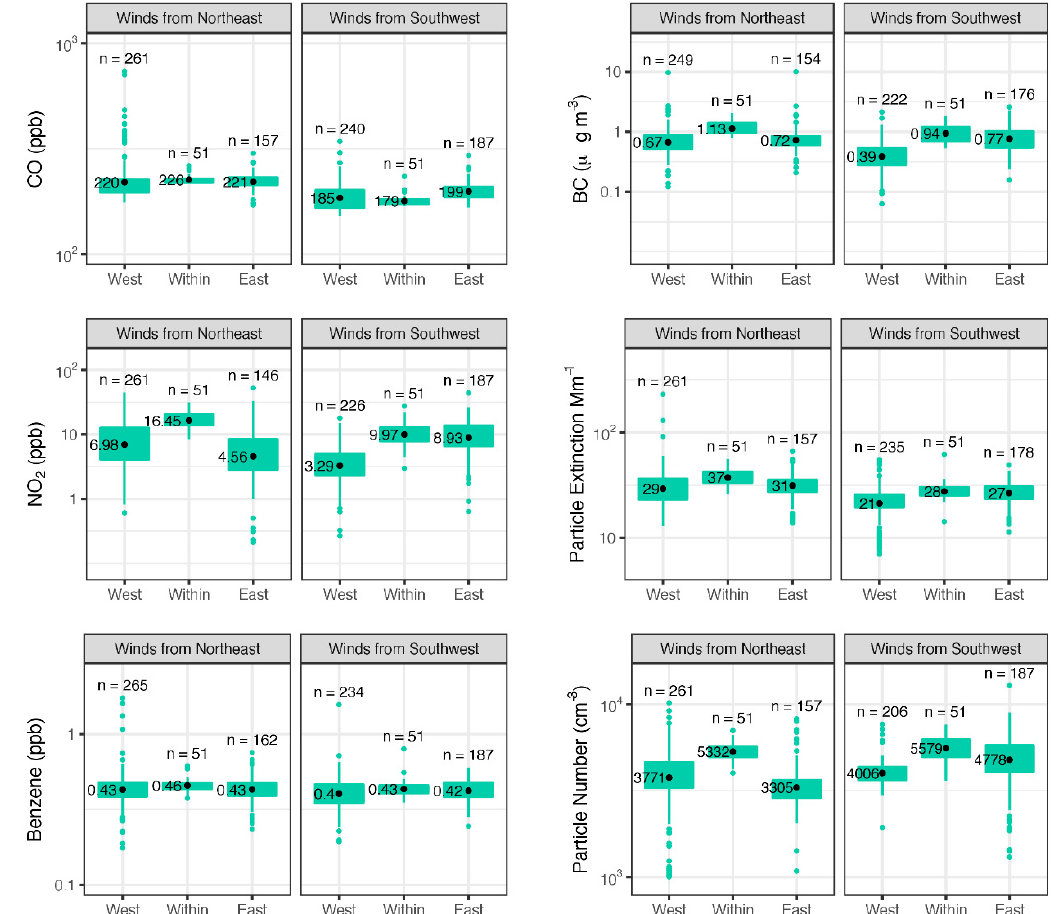
Figure 5. Concentration geometric means (black points) and box-and-whisker plots for concentrations aggregated by 50 m road segment and hour on road segments representing upwind, within, and downwind of the rail yard during cross-wind conditions. Boxes represent 25th and 75th quantiles, outlier points are measurements greater than 1.5 times the interquartile range away from the edge of the box. All measurements are plotted on a log-scale.